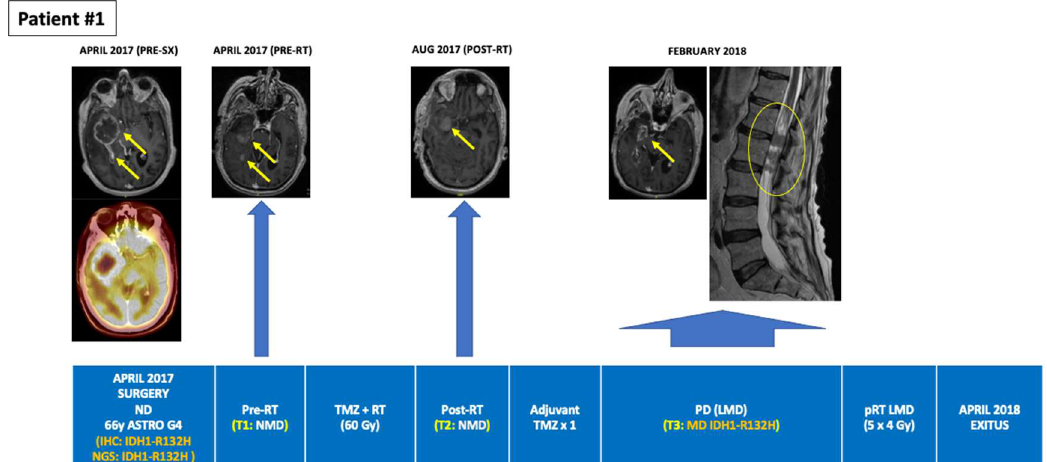
Figure 1. Tumour evolution in BEAMing ctDNA-positive patient #1. A 35-year-old man was diag- nosed with a large left temporal IDH1-R132H mutant and MGMT unmethylated glioblastoma in- volving the Wernicke area. Partial tumor resection was followed by concurrent RT + TMZ then fol-